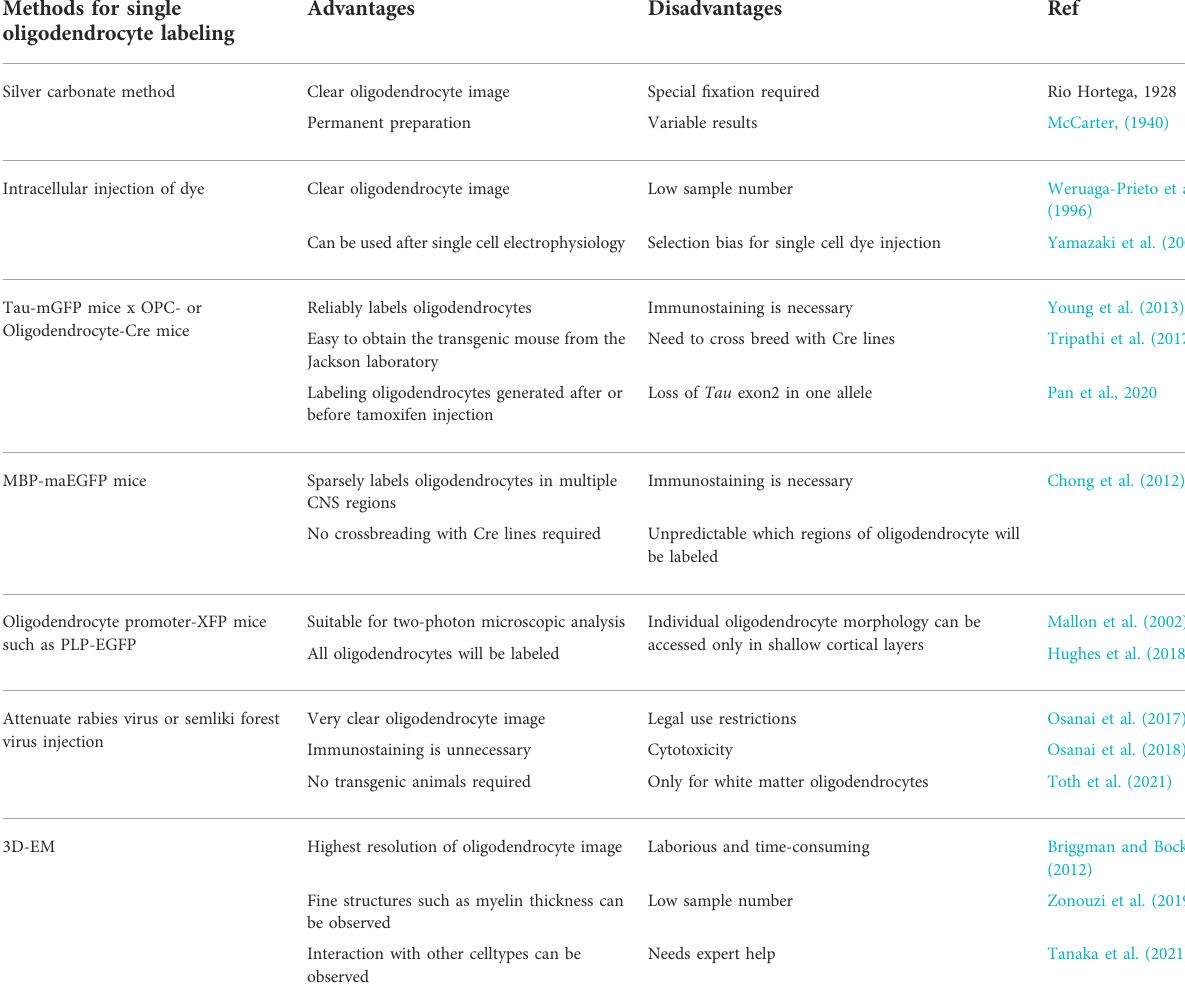
TABLE 1 The characteristics of the methods for observation of individual oligodendrocytes.